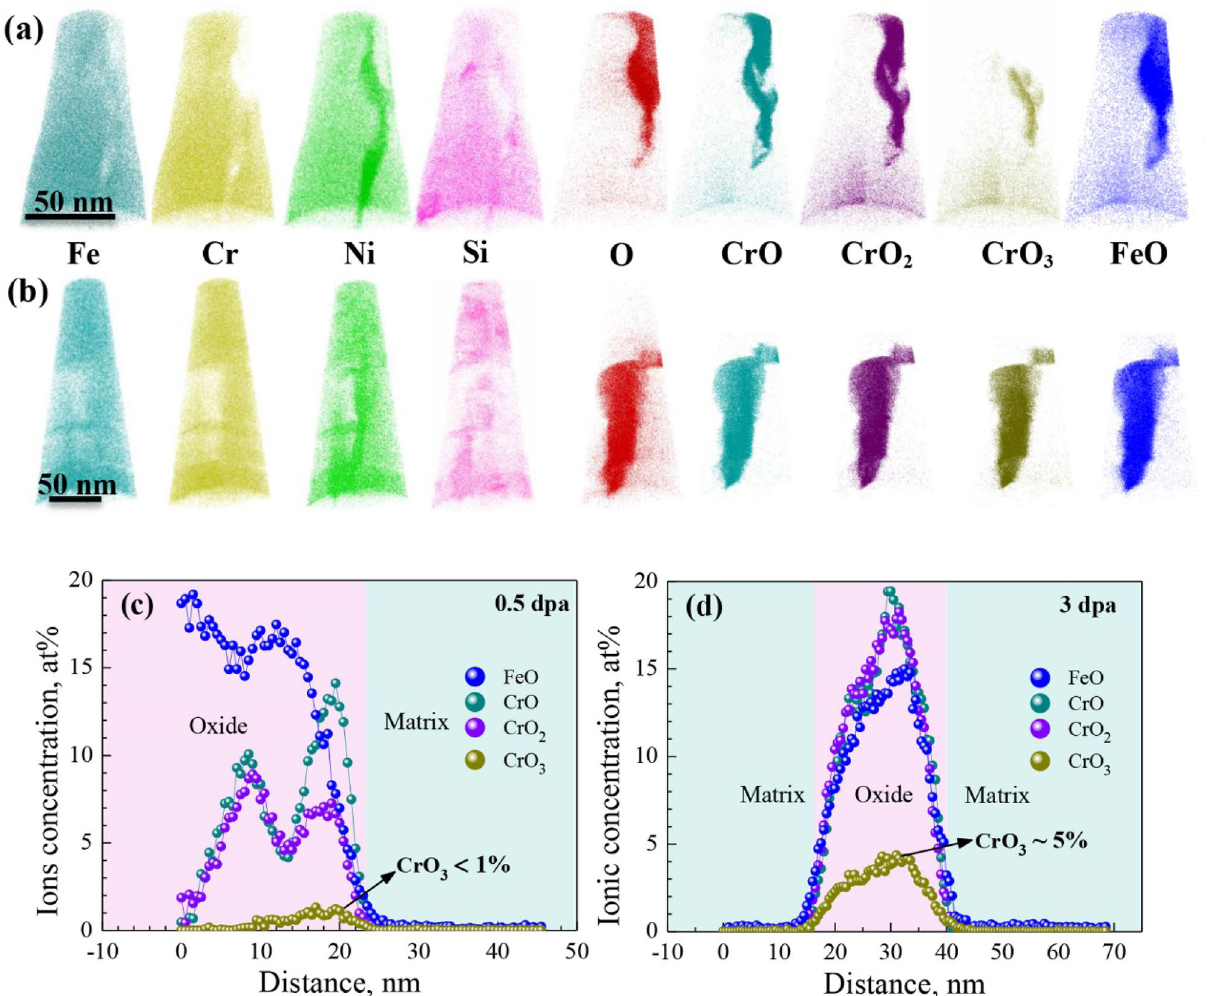
Figure 5. ( a ) and ( b ) Atom density maps showing the evaporated species for the grain boundary oxides on the 0.5- and 3-dpa irradiated specimens. The orientation of both data sets is identical to the orientation in Fig. 2a,b, where all ions of these data sets are shown in the same map. ( c ) and ( d ) Corresponding ions concentration profiles across the grain boundary oxides. *Atom density maps in this figure were reconstructed using the commercial CAMECA Imago Visualization and Analysis Software package (IVAS, Version 3.6.8). URL link: https:// www. cameca.